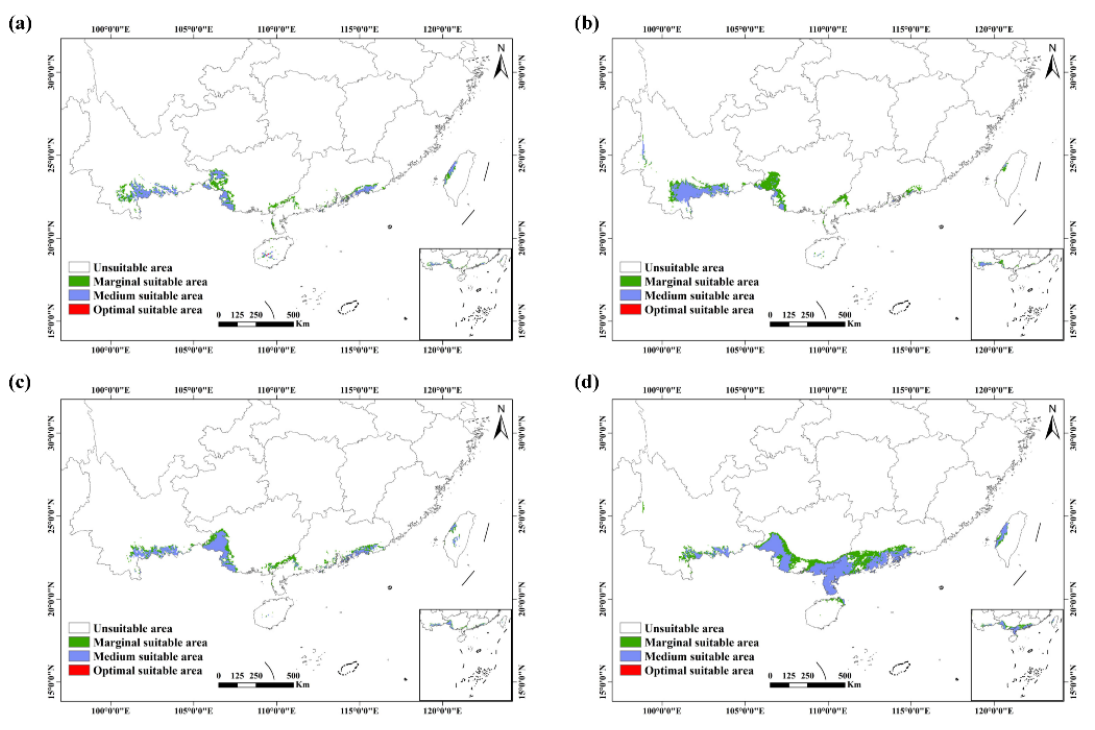
Figure 5. Projected potential distribution maps of H. tetratepala under future periods (2050s) in MIROC6 models: ( a ) SSP 2.6, ( b ) SSP 4.5, ( c ) SSP 7.0, and ( d ) SSP 8.5.